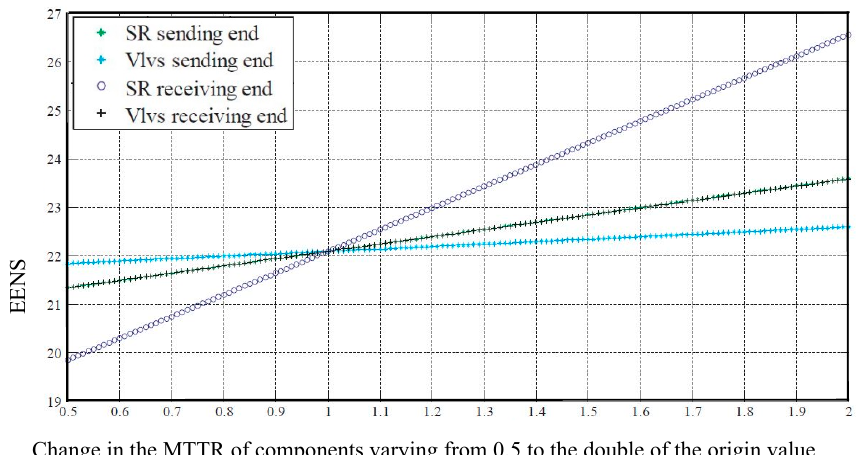
Figure 7. Electrical Energy Not Supplied (EENS) for different MTTRs computed by means of the multi-state matrix approach computed by J.S.C. Jimenez et al. in [20].